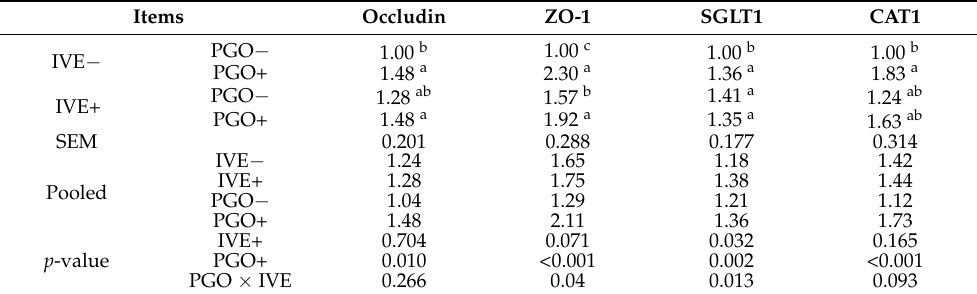
Table 6. Effect of probiotics with added glucose oxidase (PGO) and Illicium verum extracts (IVE) on the relative mRNA expression of jejunum in weaned piglets 1 .